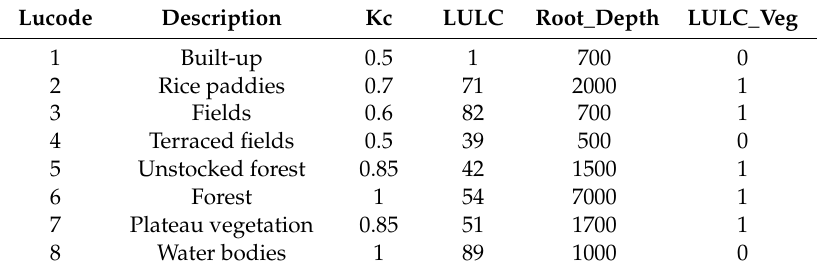
Table 2. Biophysical parameters linked to land-cover characteristics in North Korea. Lucode Description Kc LULC Root_Depth LULC_Veg 1 Built-up 0.5 1 700 0 2 Rice paddies 0.7 71 2000 1 3 Fields 0.6 82 700 1 4 Terraced fields 0.5 39 500 0 5 Unstocked forest 0.85 42 1500 1 6 Forest 1 54 7000 1 7 Plateau vegetation 0.85 51 1700 1 8 Water bodies 1 89 1000